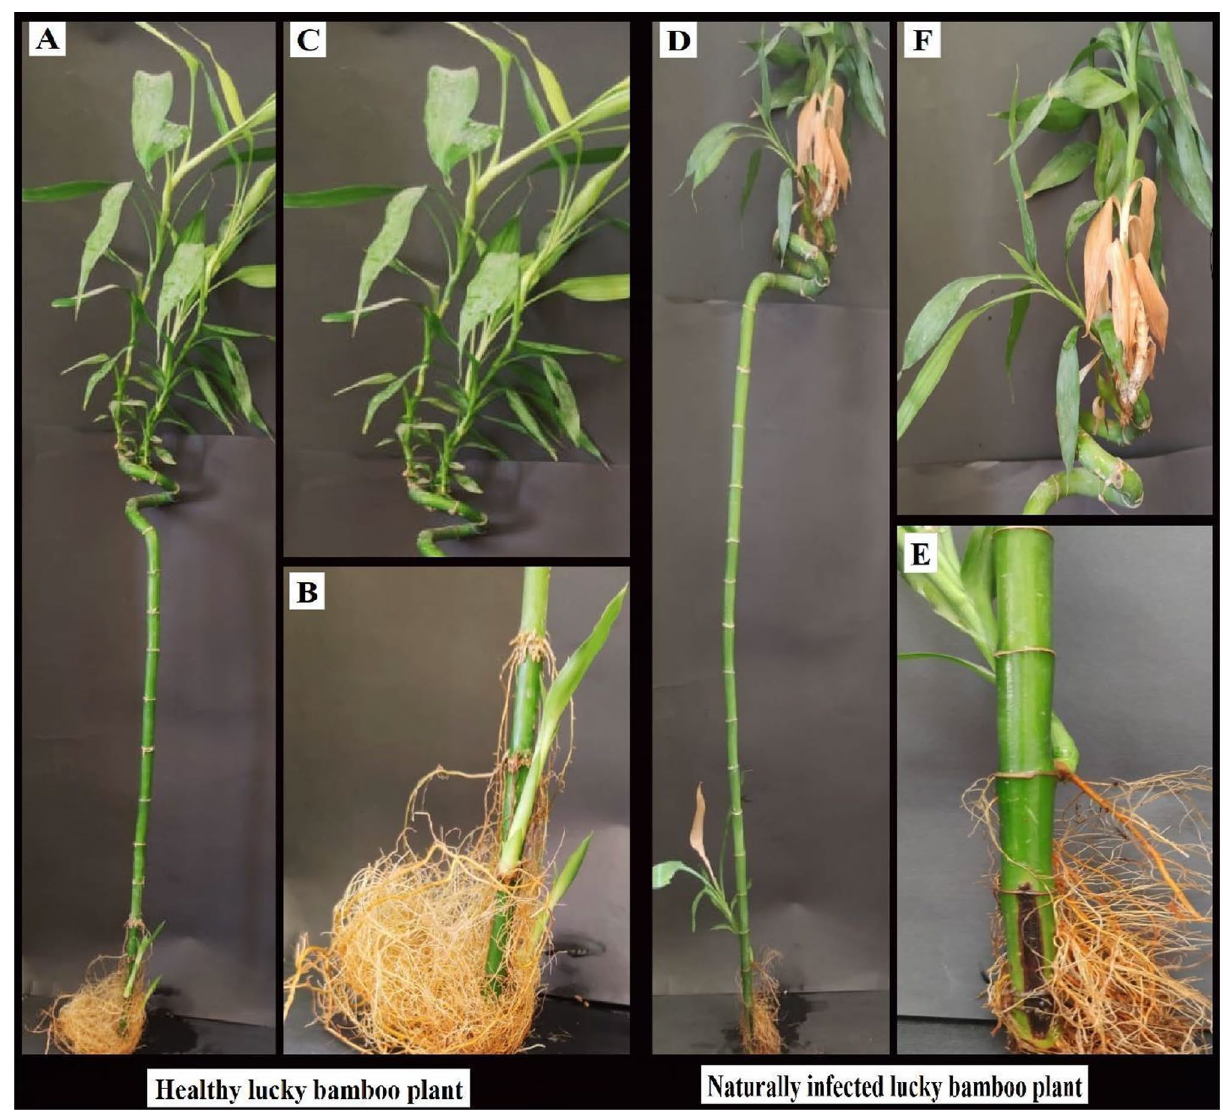
Figure 1. Appearance healthy and naturally infected for lucky bamboo ( Dracaena sanderiana hort. ex. Mast.), and Symptoms of basal stems and roots ( A & D ) complete plant form ( B ) healthy basal stem and -brown lesions) ( F ) few yellowing roots, ( C ) healthy leaves, ( E ) basal stem rot, root rot (infected basal stem have dry of brown to reddish